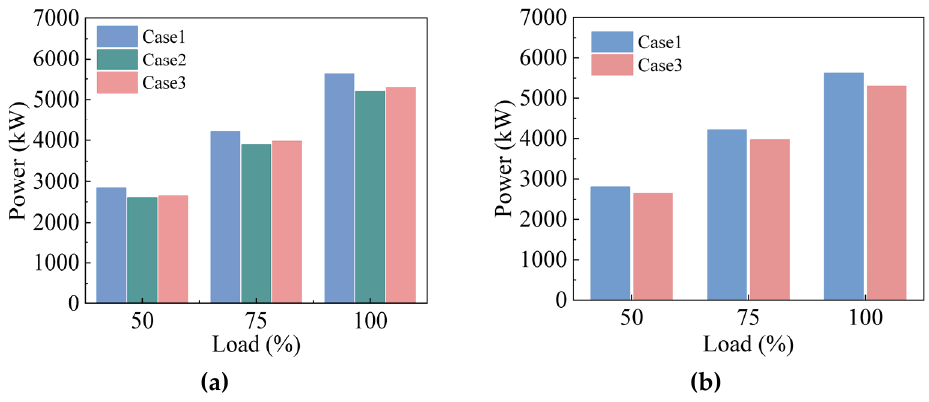
Figure 8. The trend of power for variable EBP at different loads. ( a ) EBP = 10 kPa; ( b ) EBP = 25 kPa.